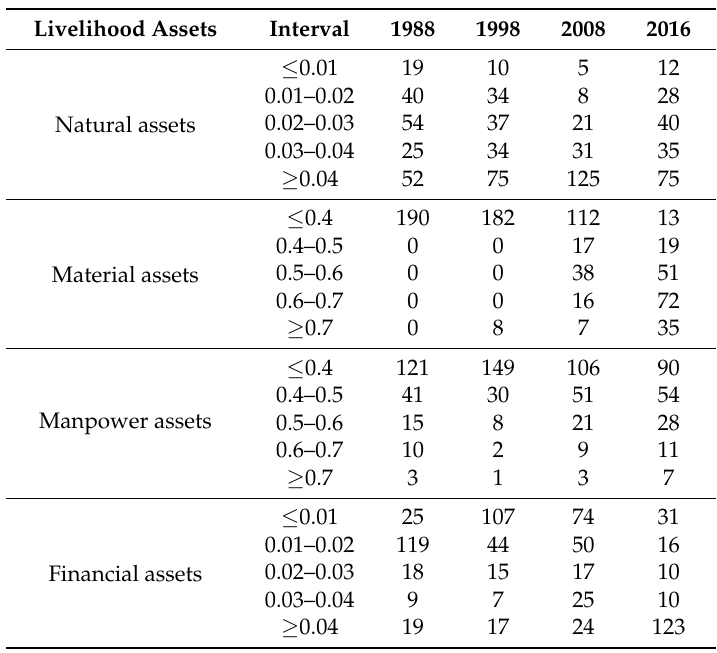
Table 4. The allocation of livelihood assets among households from 1988 to